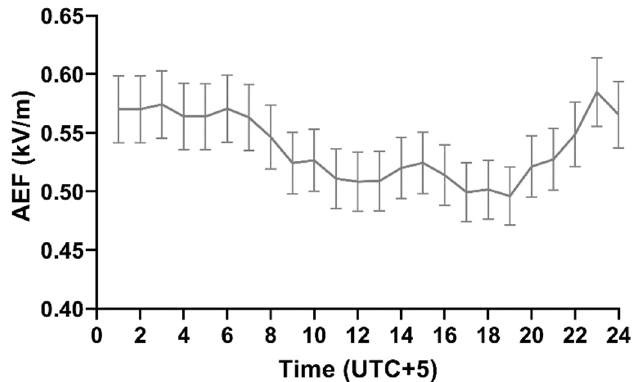
Figure 4. Average atmospheric electric field daily variation on 40 fair-weather days at the Antarctic Chinese Zhongshan Station during the 5-month measurement period (1 March–1 August 2022) (the average curve for these 12 days is represented by the black curve, and the error bars represent the corresponding standard deviations).